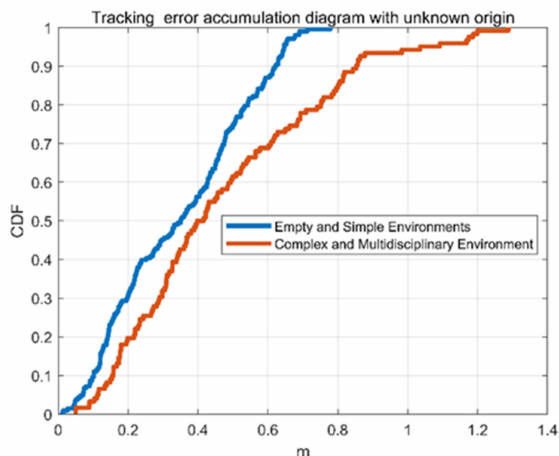
Figure 16. Error accumulation diagram of the trajectory errors in Environment 1 and Environment 2. Figure 17 is the CDF of the trajectory errors with different trajectory shapes. The blue line is the cumulative error of the vertical trajectory, the red line is the cumulative error of the U-shaped trajectory, and the orange line is the cumulative error of the circular trajectory. It can be seen from the figure that the trajectory error is related to the number of turns of the trajectory. When the trajectory is circular, the number of turns is largest. Therefore, the cumulative error is the largest. The errors are minimal when the trajectory is straight.